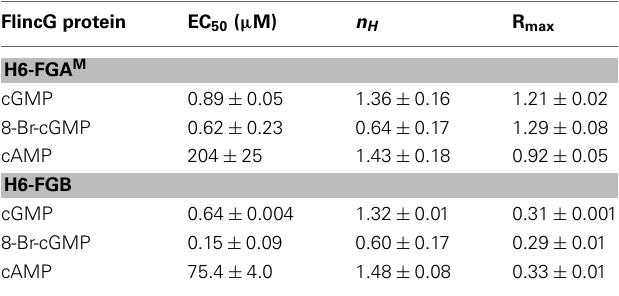
Table 2 | NO concentration-response curve parameters